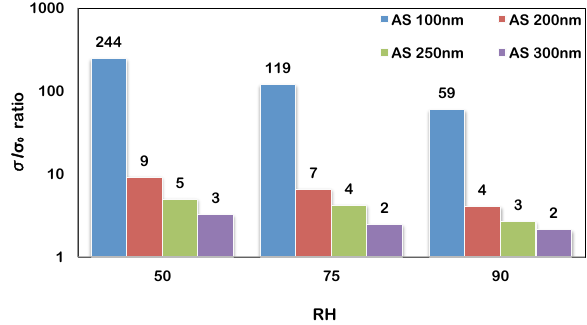
Fig. 3. The ratio of the extinction cross section after reaction ( σ ; cm 2 ) to the initial extinction cross section ( σ 0 ) of the dry AS par- ticles with initial sizes of 100nm (blue), 200nm (red), 250nm (green), and 300nm (purple) after a ∼ 1h heterogeneous reaction with glyoxal gas at RH values varying from 50% to